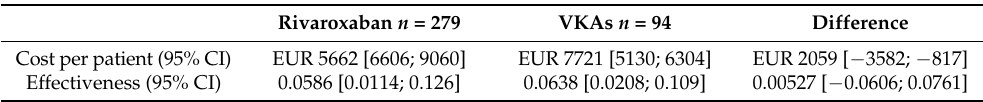
Table 4. Costs and effectiveness for each anticoagulant treatment (weighted